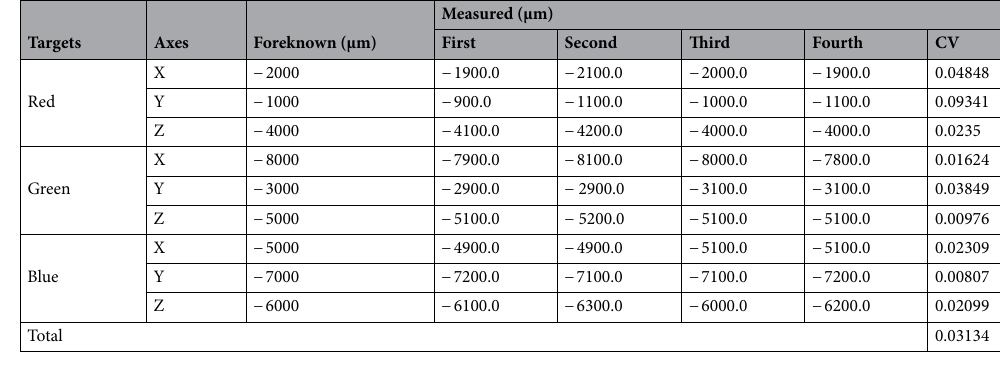
Table 1. Foreknown central positions of three targets measured in the data-out molds and the coefficients of variation (CV) from the measurements in four different periods. Multiple comparisons between foreknown and measured values or among different rounds measured, with Tukey HSD, result in no statistical significance (N = 45, for all, p = 0.9999857–1).